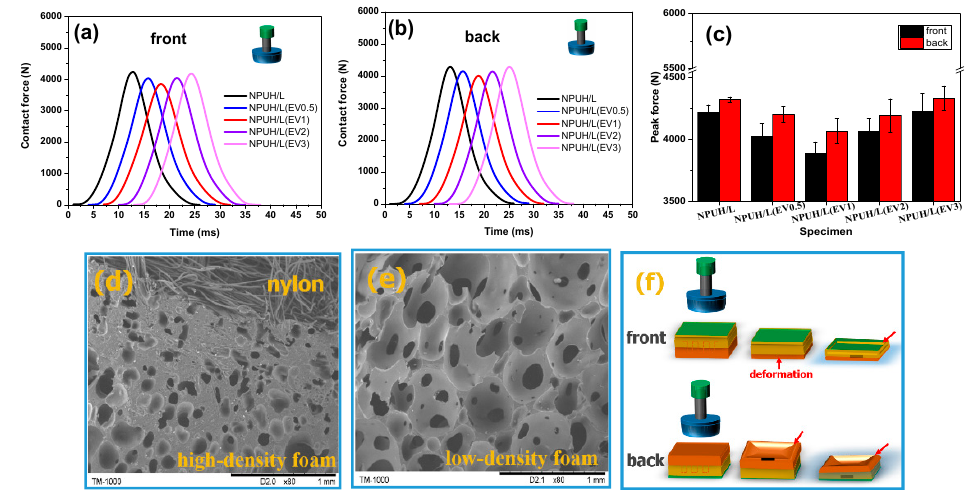
Figure 10. ( a , b ) Impact signals of bionic composites with different EV contents; ( c ) Peak contact force of bionic composites with various EV contents; ( d ) The nylon–foam interface of bionic composite; ( e ) The microstructure of low-density foam; ( f ) The diagram of deformation process during impact.